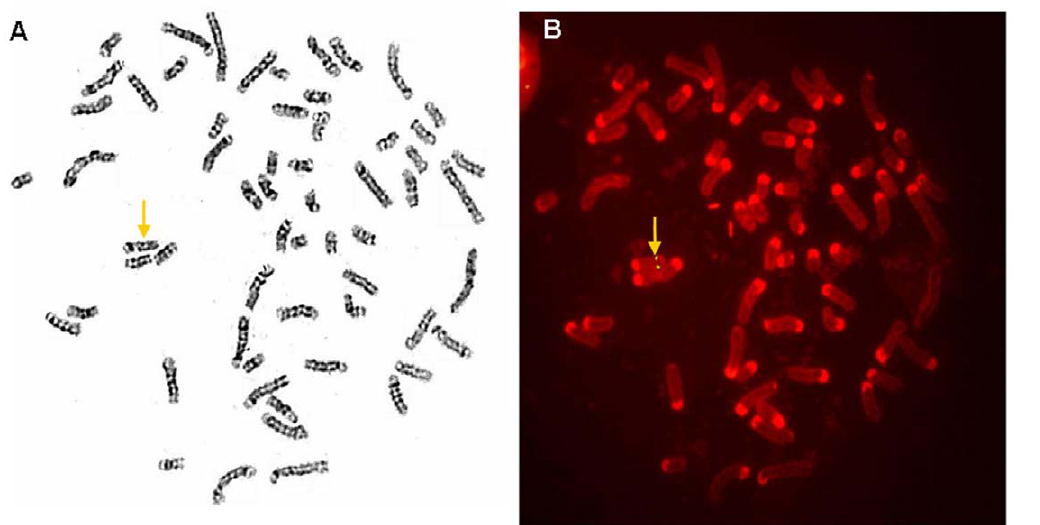
Figure 4. Verification of the transgene chromosomal location by FISH analysis. Detection of the transgene loci in the transgenic cow # 040825 by (A) the GTG-banding pattern of metaphase spreads before hybridization and (B) the same metaphase after FISH . The arrows indicate the transgene integration site on chromosome 15.